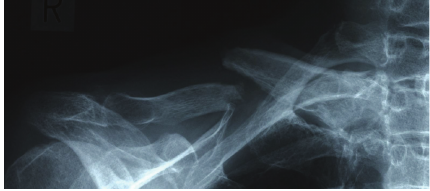
Figure 1: Preoperative radiograph of the fractured right clavicle demonstrating atrophic nonunion.